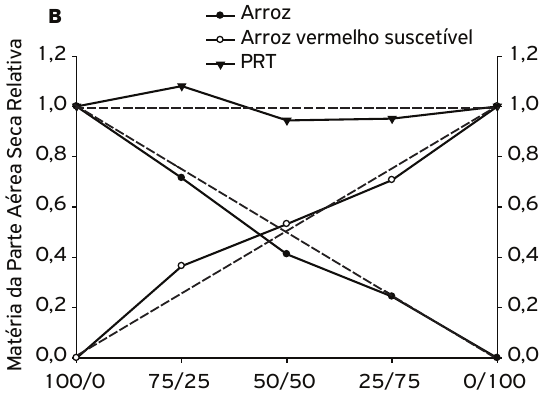
Figura 1. Produtividade relativa (PR) e total (PRT) para área foliar (A) e para matéria da parte aérea seca (B) de plantas de arroz e arroz-vermelho suscetível, FAEM/UFPel, Capão do Leão (RS),